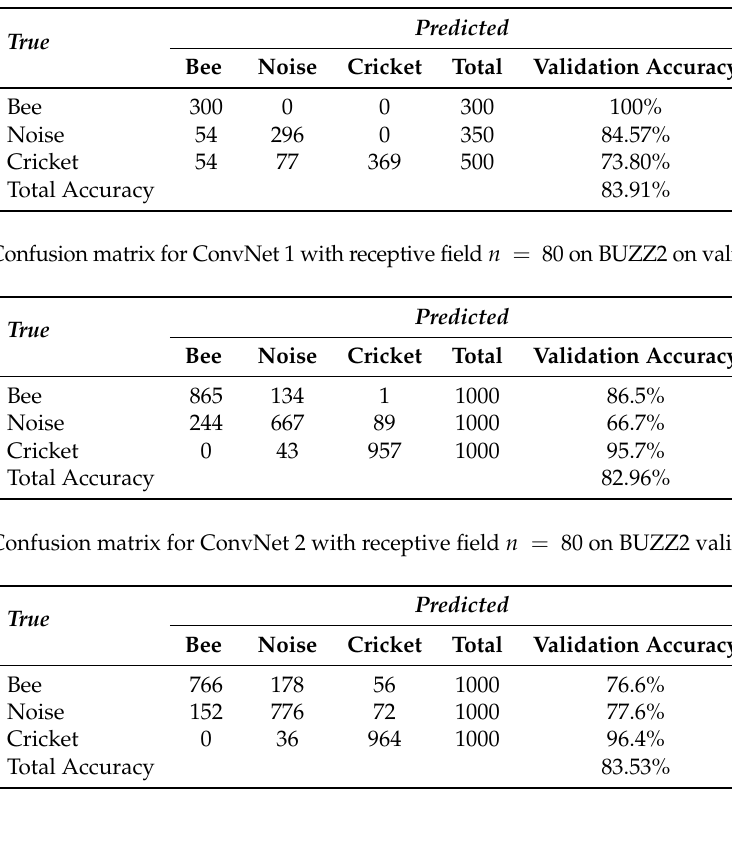
Table A11. Confusion matrix for SVM OVR with no feature scaling on BUZZ1 validation dataset.